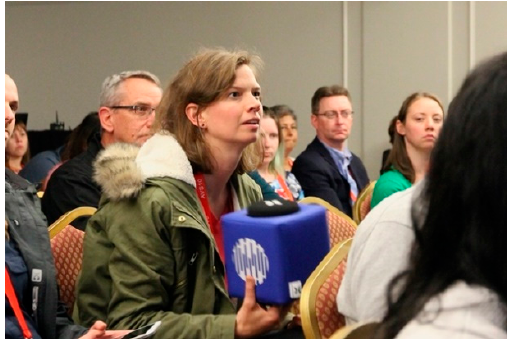
Figure 1. Johanna Fraser asking a question using the “Catchbox” roving microphone at AVS10.